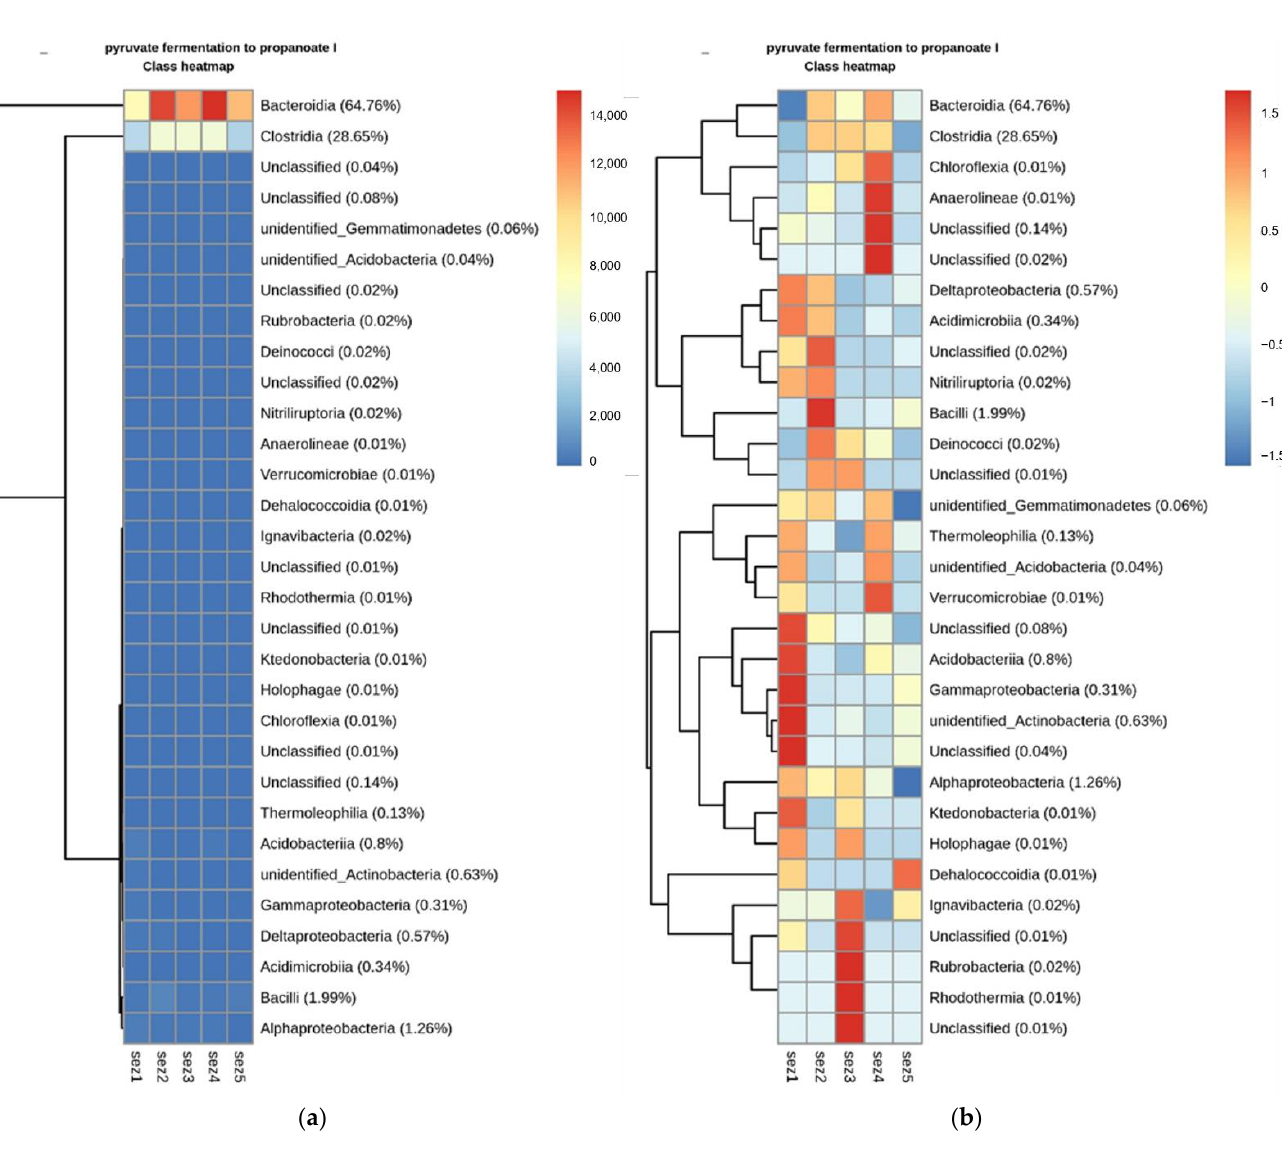
Figure A3. Functional heatmaps of pyruvate fermentation to propanoate I: ( a ) absolute counts and ( b ) autoscaled counts, aggregated at the class level.